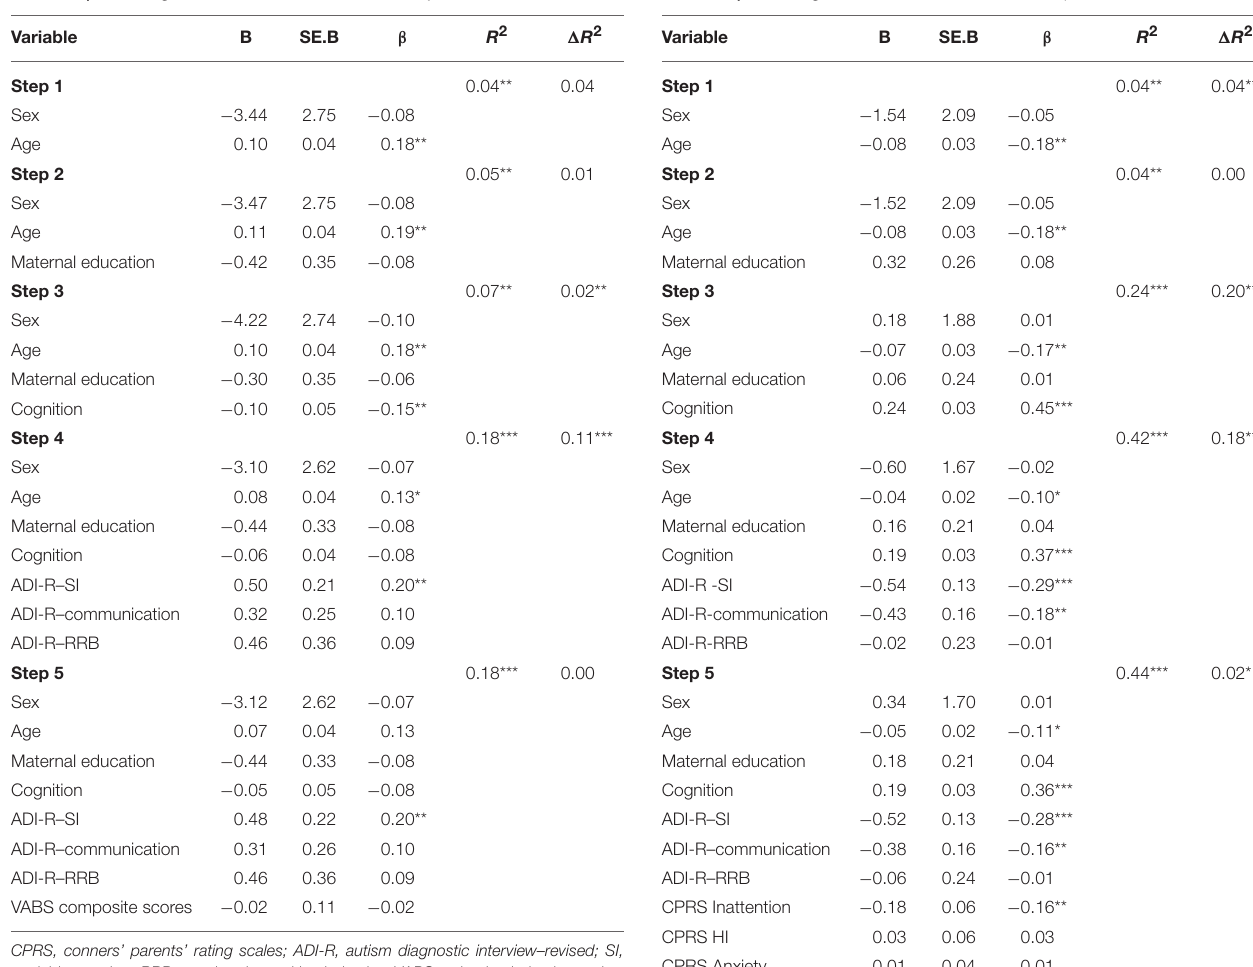
TABLE 9 | Linear regression model for the VABS composite